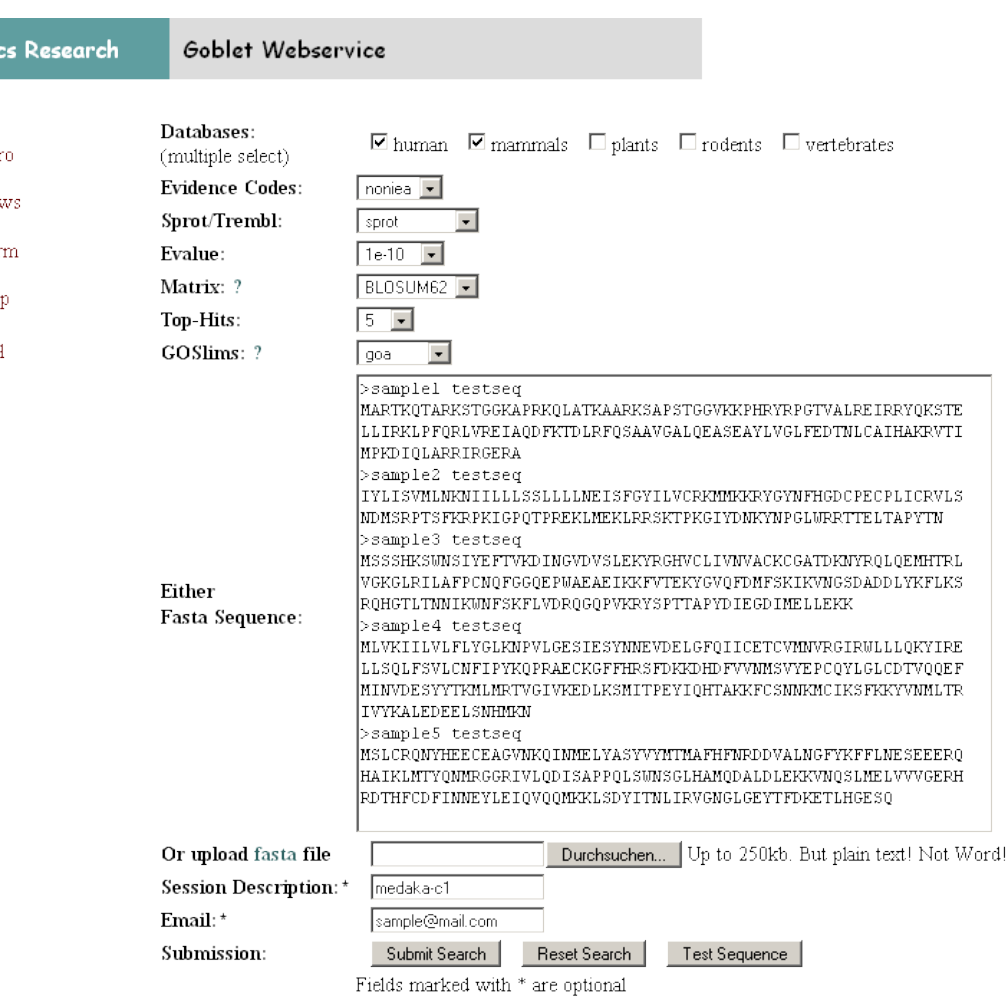
Figure 2: GOblet sequence submission web